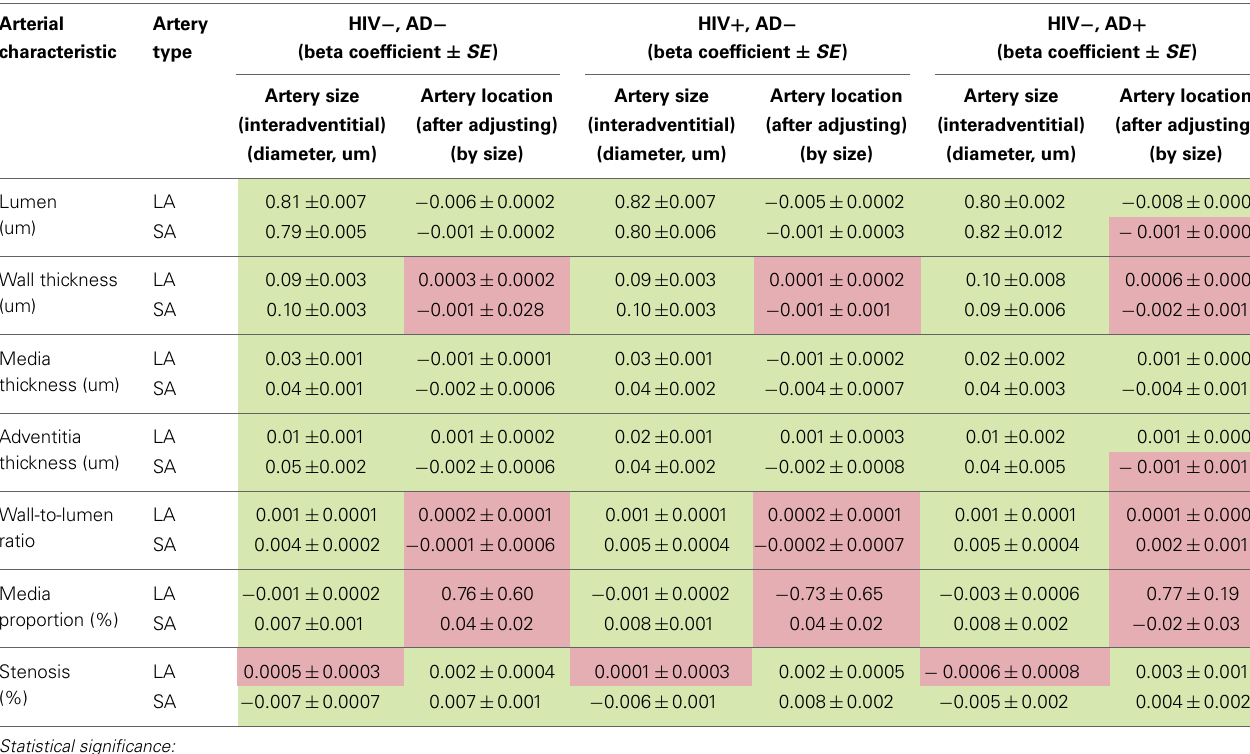
Table 4 | Beta coefficients for arterial size in association with arterial characteristics by clinical group.